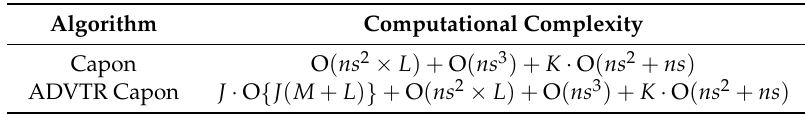
Table 1. Computational complexity